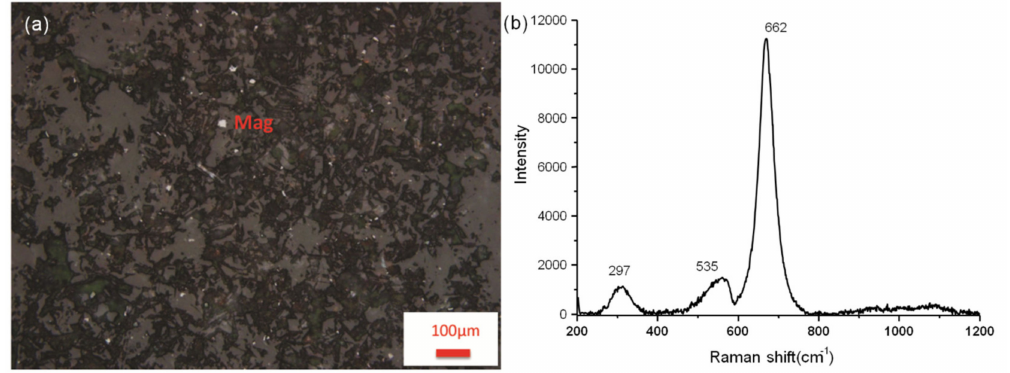
Figure 8. Magnetite in the host rock of yellow agate under reflected light ( a ) and its Raman spectrum ( b ). It is noted that the Xuanhua-type agate is a very popular gem-material. It may have a very bright color in red and yellow, and the two colors are various, occasionally occupying hematite and/or yellow goethite, such as dendritic goethite, banded hematite and